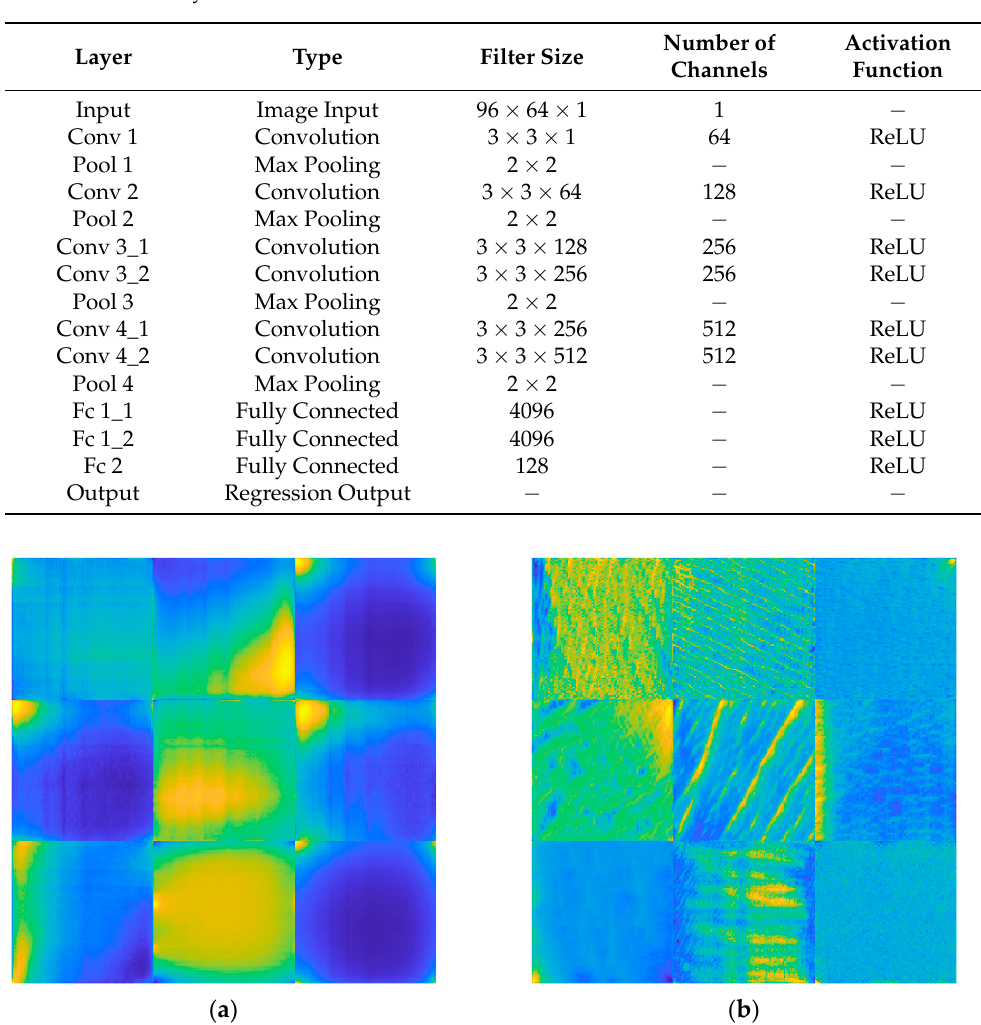
Figure 3. VGGish layers: ( a ) example of features learned in the layer Conv 2; ( b ) example of features learned in the layer Conv 3_1.